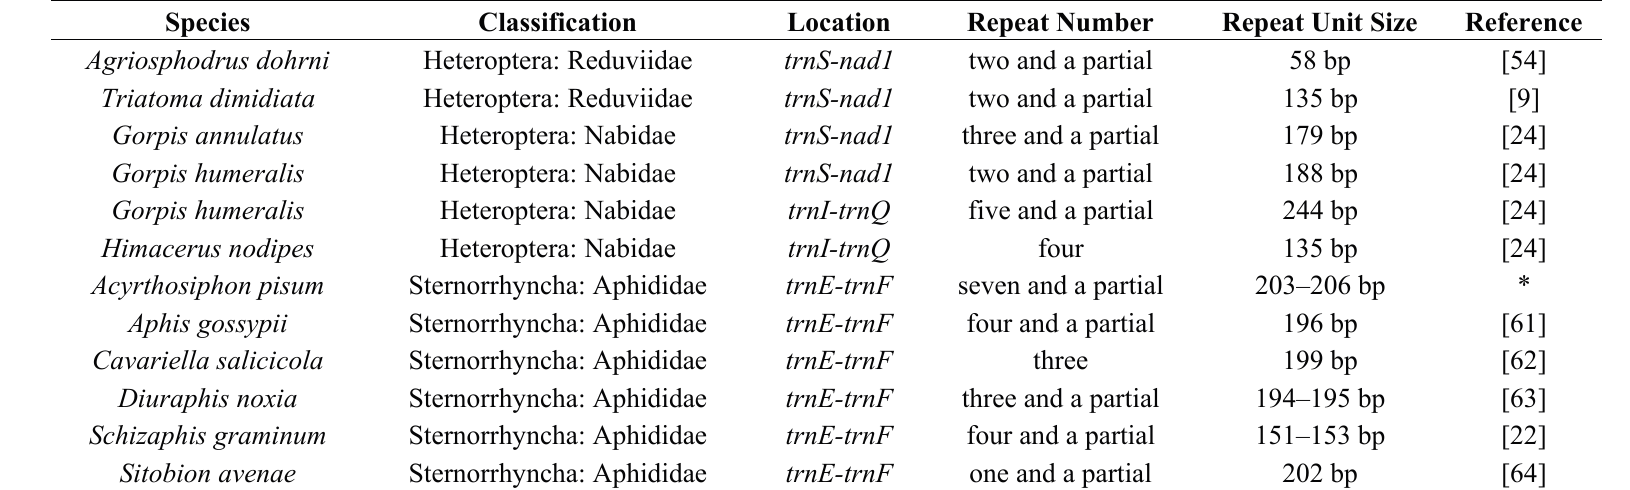
Table 2. Repeat regions of hemipteran